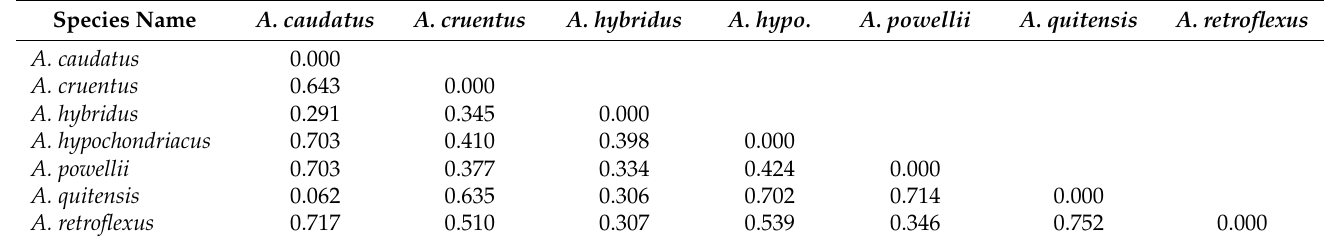
Table 3. Pairwise F ST values among species of grain amaranths and wild relatives of the Amaranthus